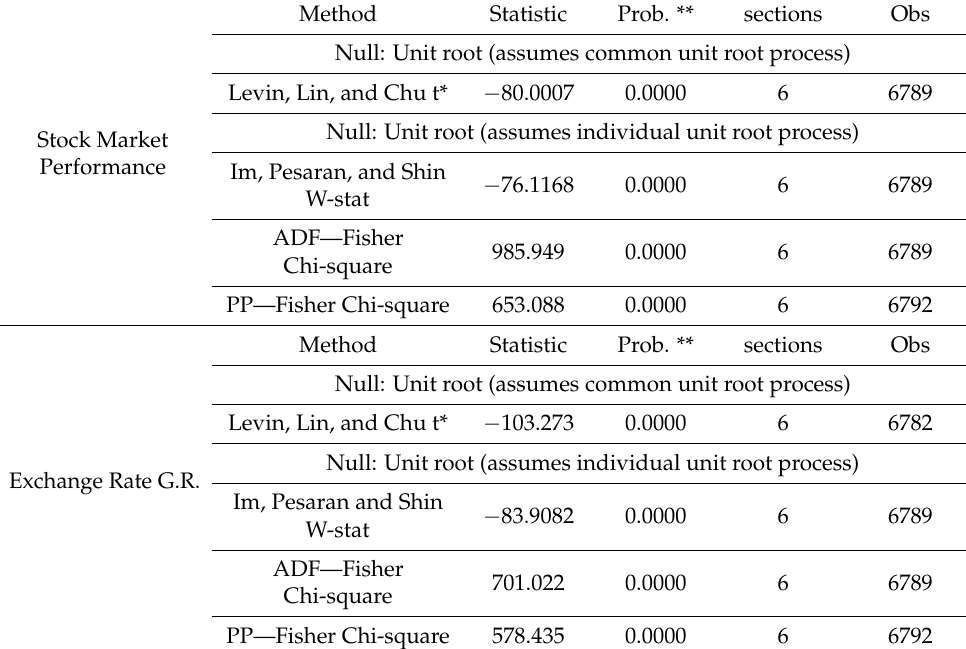
Table A1. Panel unit-root